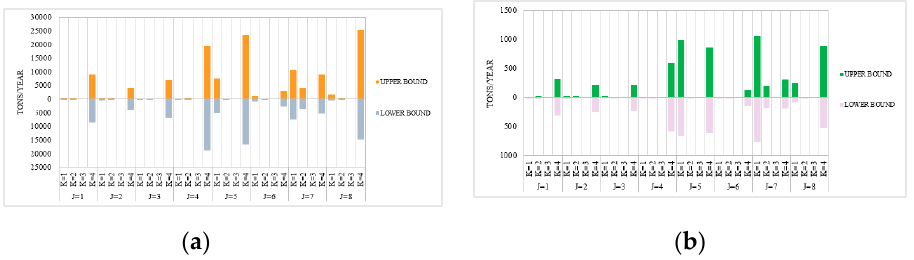
Figure 1. The emissions of COD and ammonia nitrogen from different water use departments in different areas of the Yinma River Basin in the first planning period. ( a ) The emissions of COD in the first planning period; ( b ) The emissions of ammonia nitrogen in the first planning period.